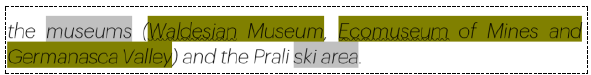
Figure 13. Concepts, relations and properties of tourism.